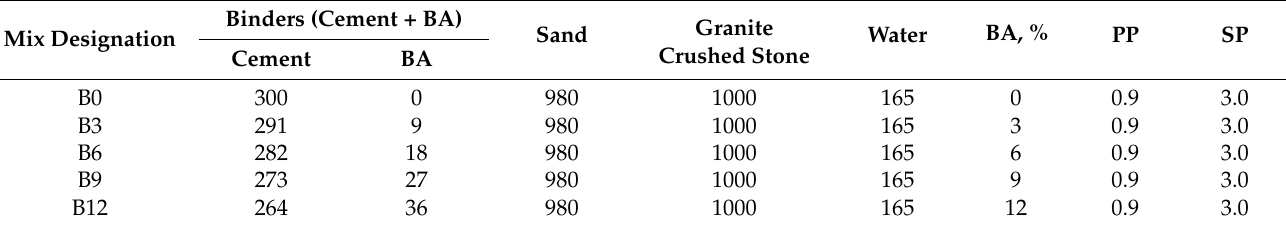
Table 4. Compositions of concrete mixes (kg/m 3